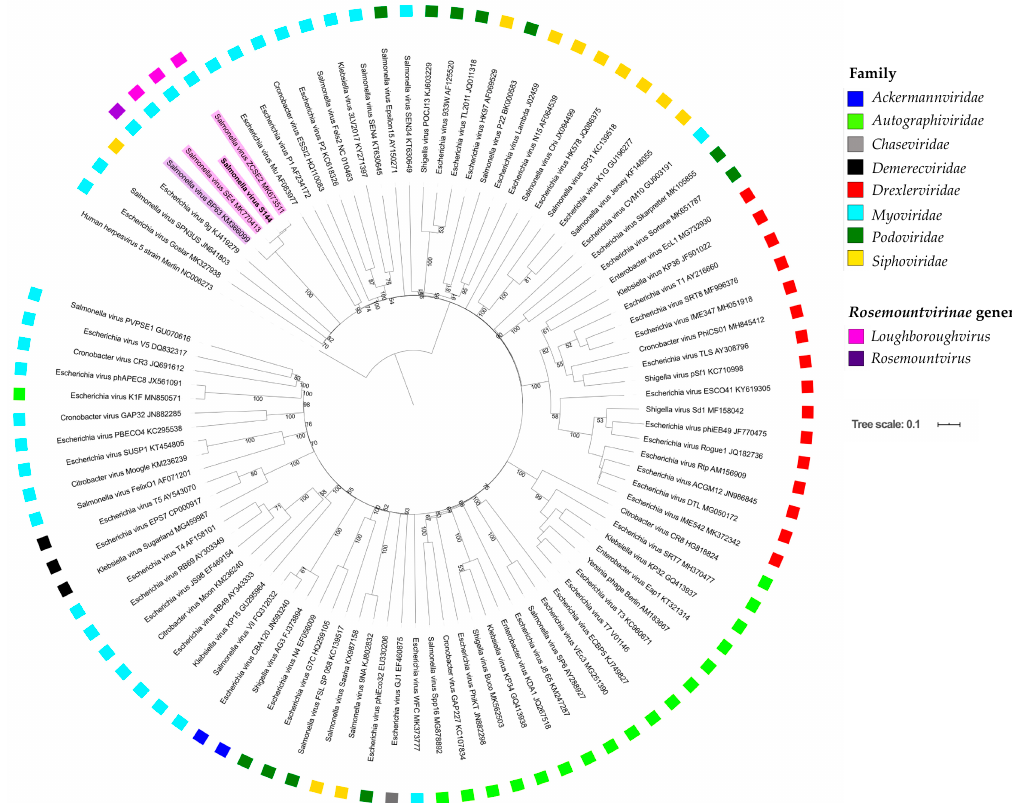
Figure 4. Phylogenomic analysis at the nucleotide level of phage S144, its two closest relatives, and 93 phage genomes representative for each genus infecting Enterobacteriaceae strains and the genome of the human herpesvirus as outgroup. The tree has been built using VICTOR with the formula d0, recommended for phages, and aesthetically modified with iTOL. Bootstrap values higher than 50% are indicated on the branches. The branch lengths of the resulting VICTOR trees are scaled in terms of the used distance formula. S144 and the other two phages in the Loughboroughvirus virus are highlighted in pink and the representative from the closest genus, the Rosemountvirus genus, in purple. For each phage, we indicated the accession number and the family, according to ICTV.